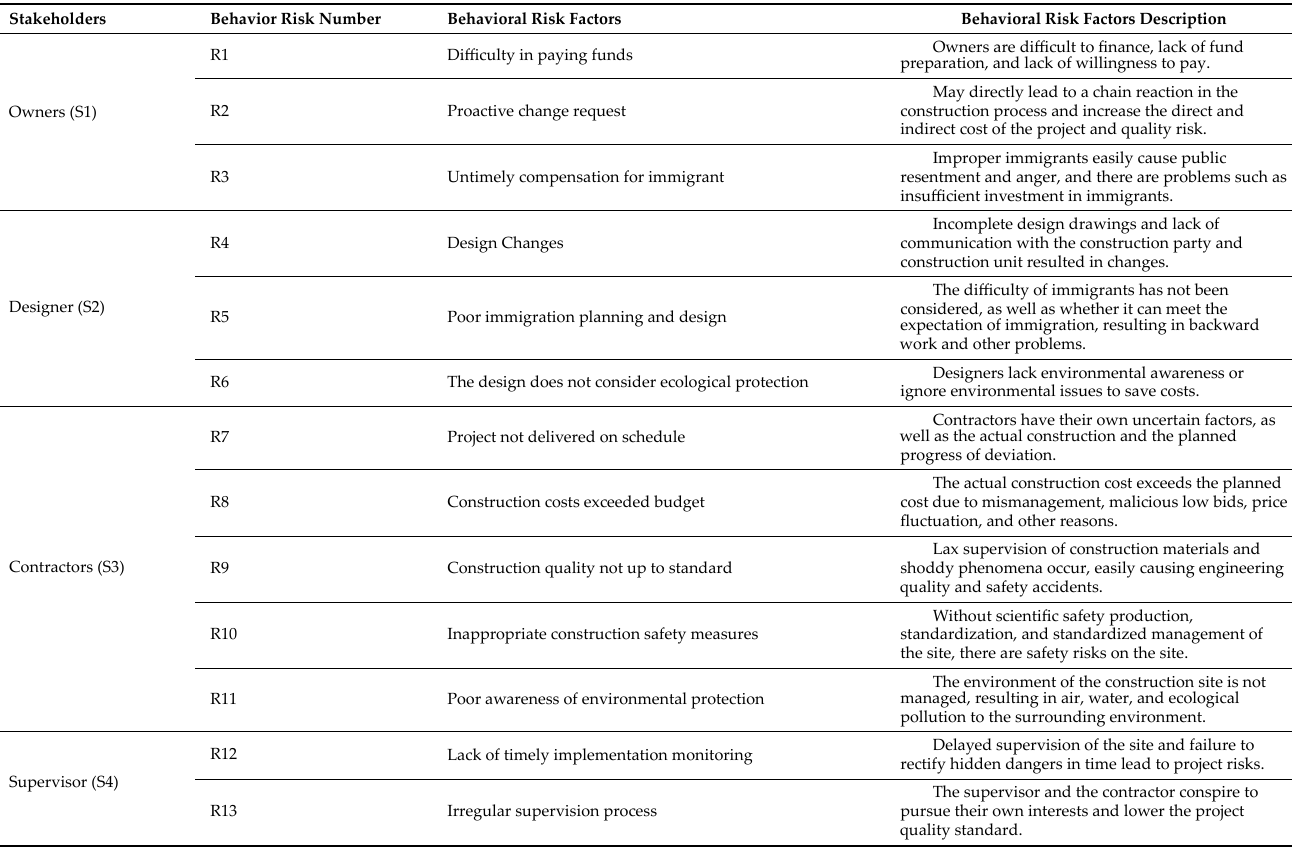
Table 4. Identification and classification of behavioral risk factors for hydropower